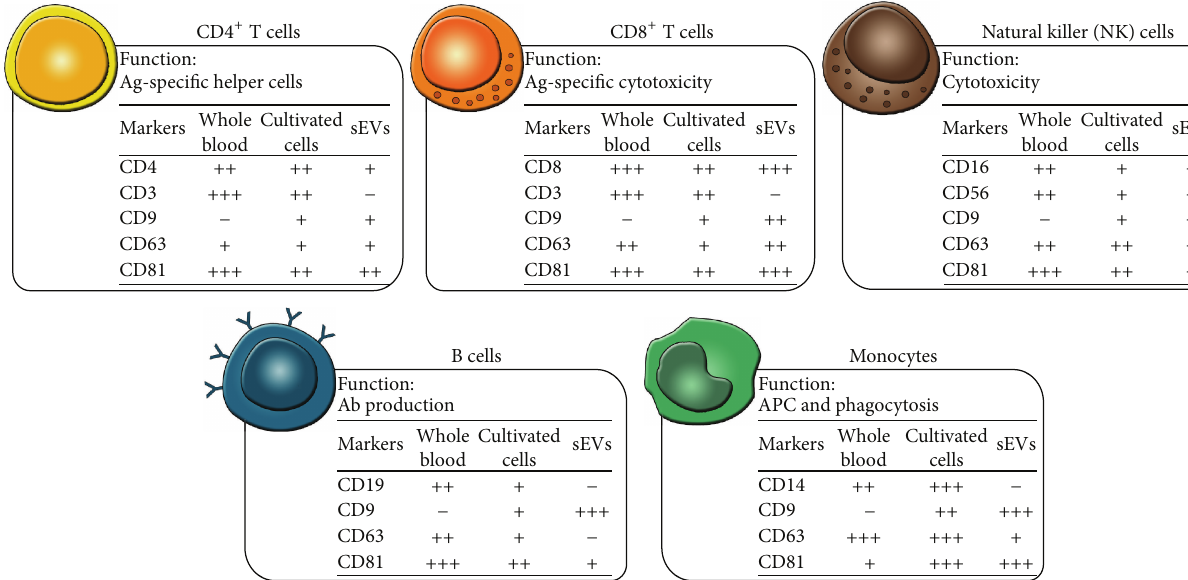
Figure 4: Summary of results on the presence of selected lineage-specific and vesicle-related markers on five leukocyte subpopulations and the corresponding leukocyte-derived sEVs. The expression of selected lineage-specific and vesicle-related markers was determined for freshly isolated leukocytes and for cultured leukocyte subpopulations. The cellular expression was determined by flow cytometry. The level of the different markers was grouped into negative ( − ), low (+), intermediate (++), or high (+++) corresponding to the following signal intensities: < 100, 100–1000, 1000–10000, and 10000–100000, respectively. The results presented on freshly isolated leukocytes and on cultured leukocytes are based on median values of ten or three individual experiments, respectively. The EV Array determined the presence of the markers on the corresponding leukocyte-derived sEVs. The level of the different markers is grouped into negative ( − ), low (+), intermediate (++), or high (+++) corresponding to the following signal intensities: 0–0.1, 0.1–1, 1–2.5, and 2.5–5.5, respectively. The results presented on the leukocyte- derived sEVs are based on mean values of three individual experiments. Ag: antigen; Ab: antibody; APC: antigen-presenting